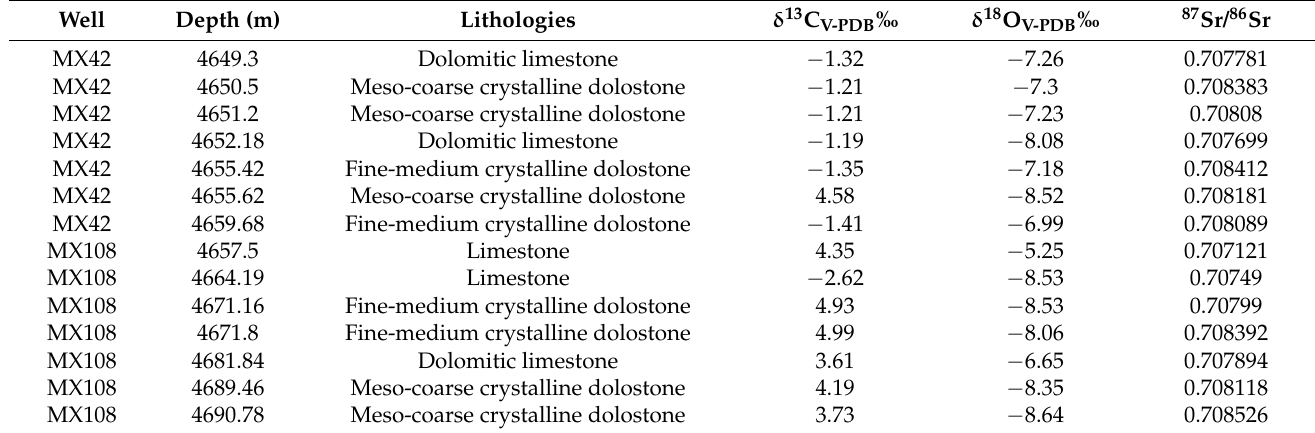
Table 4. Carbon, oxygen, and strontium isotope values of carbonate rocks in the Qixia